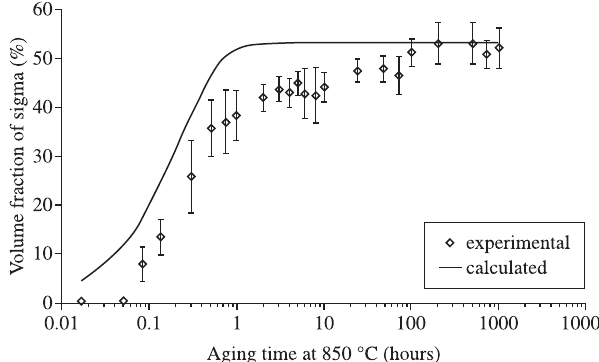
Figure 16. Experimental and calculated sigma phase content (vol. %) as a function of aging time at 850 °C.